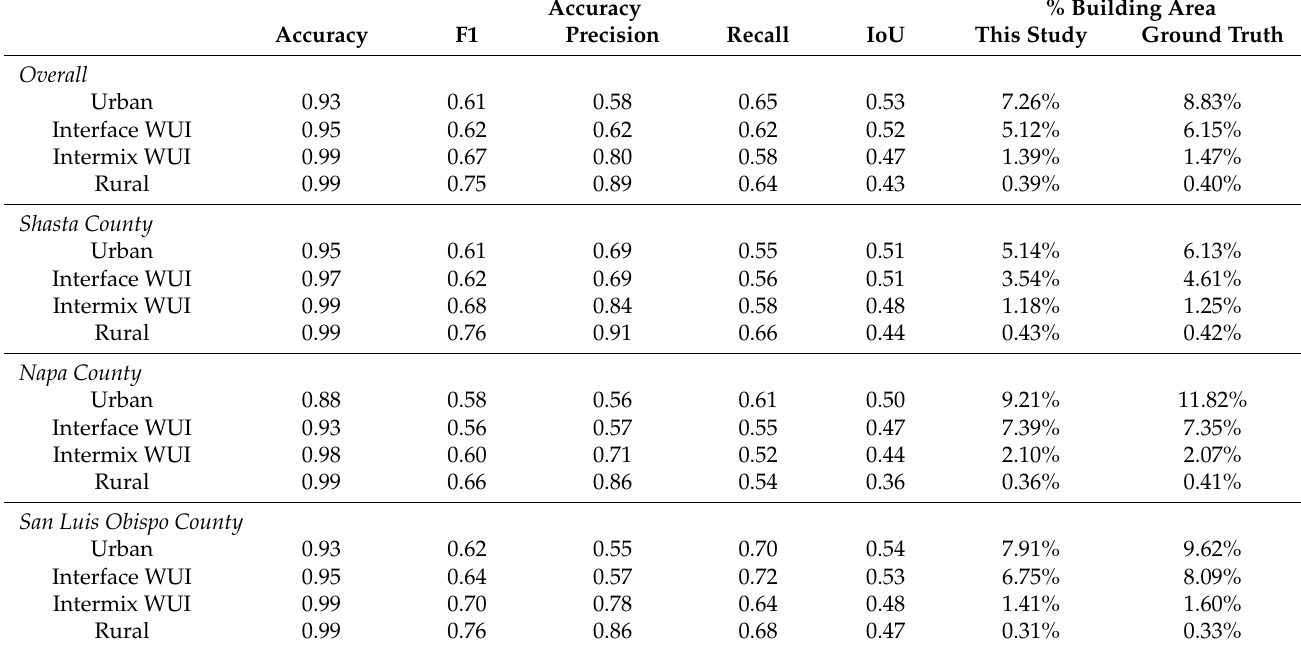
Table 2. Evaluation of building footprint mapping with the evaluation dataset at the pixel and individual object level over the whole study area and three counties in California, along the gradient of housing density, i.e., urban, Interface WUI, Intermix WUI, and rural areas, respectively. Moreover, included are the aggregated percentages of building cover from this study and reference